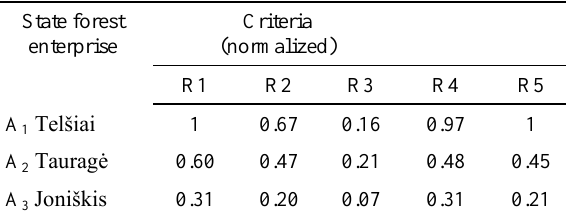
Table 5. Normalized criteria matrix for SAW calculation